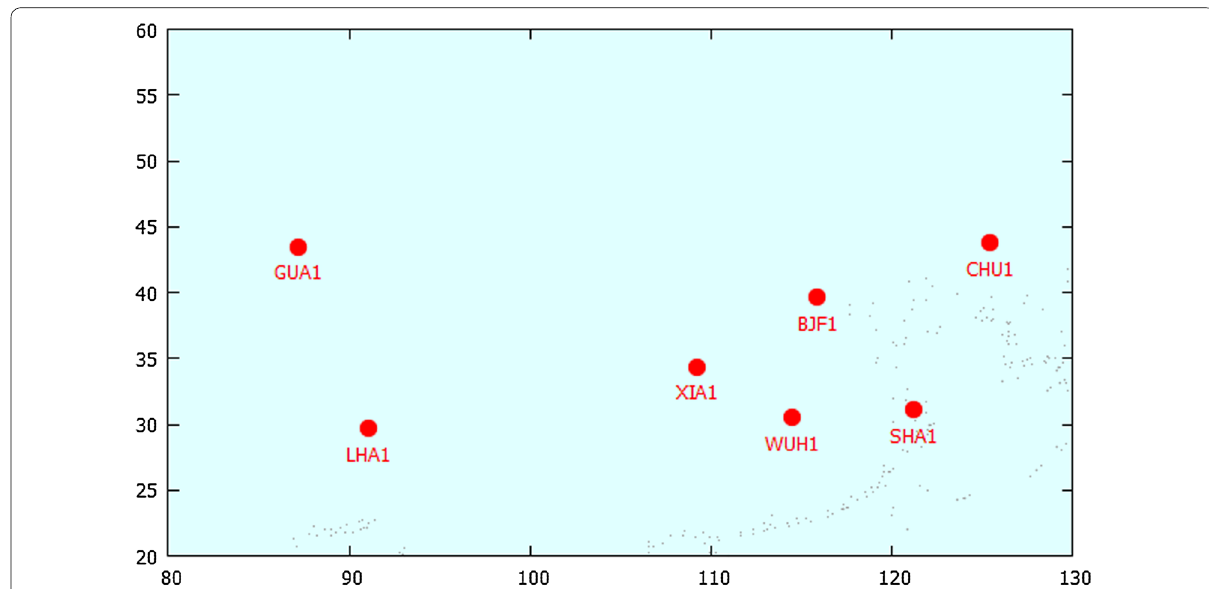
Fig. 1 The distribution of the iGMAS stations. The X- and Y-axis are longitude and latitude in degrees, respectively. The distance between the furthest stations is approximately 1700 km